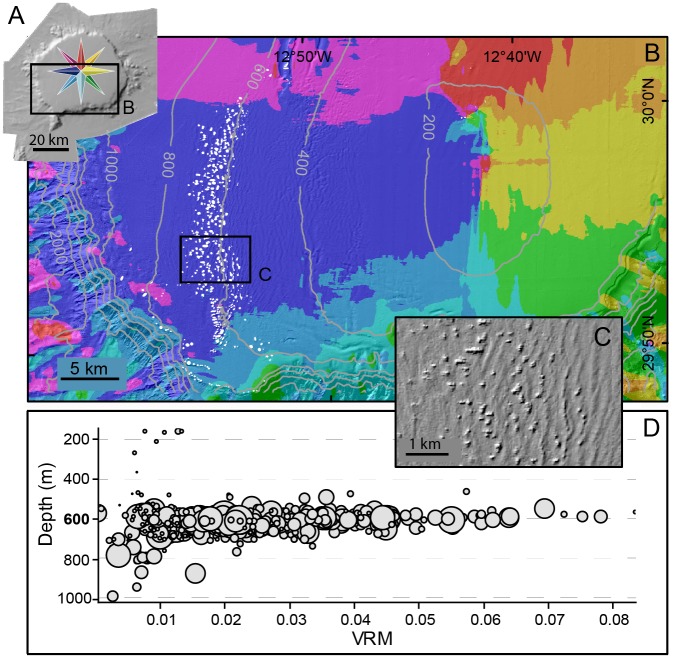
Depth-wise distribution and roughness analysis of the fresh-looking mounds on Concepcion Bank summit plateau.(A) Shaded relief of the Bank indicating area illustrated in B (color code for seafloor orientation identical to cross sections in Fig 5). (B) Seafloor orientation map of the SW quadrant of the summit plateau with white dots highlighting the location of the fresh-looking mound forming a belt of up to 4 km width, close to the 600 m isobath. Colour code in A. Location in A and Fig 7. (C) DEM detail showing scattered mounds amidst the sediment wave field. (D) Mound roughness vs. depth. Each mound is represented by a circle where diameter is proportional to mound area. Roughness has been quantified using the Vector Ruggedness Measure (VRM; Hobson [63]).